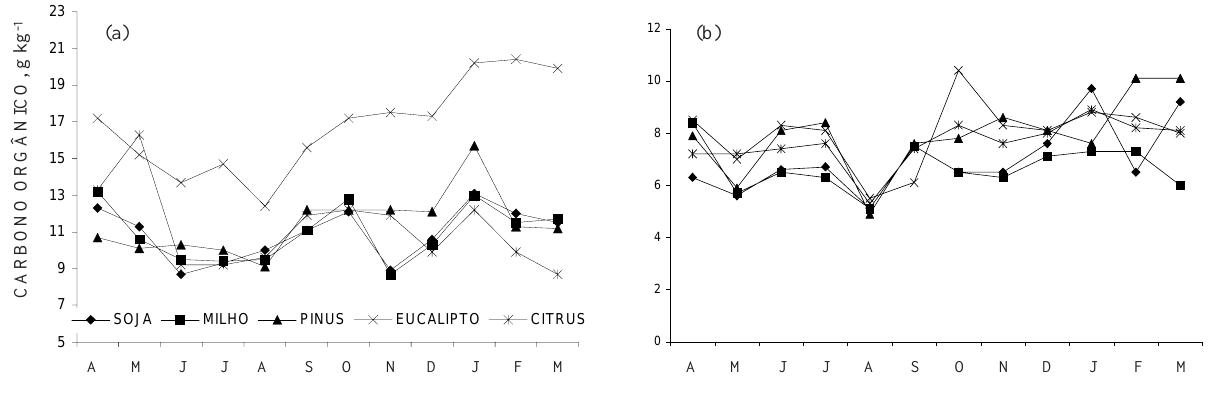
Figura 3. Carbono orgânico em amostras de LVaf (a) e LVd (b) cultivadas com soja, milho, pinus, eucalipto e citrus, em função do tempo de